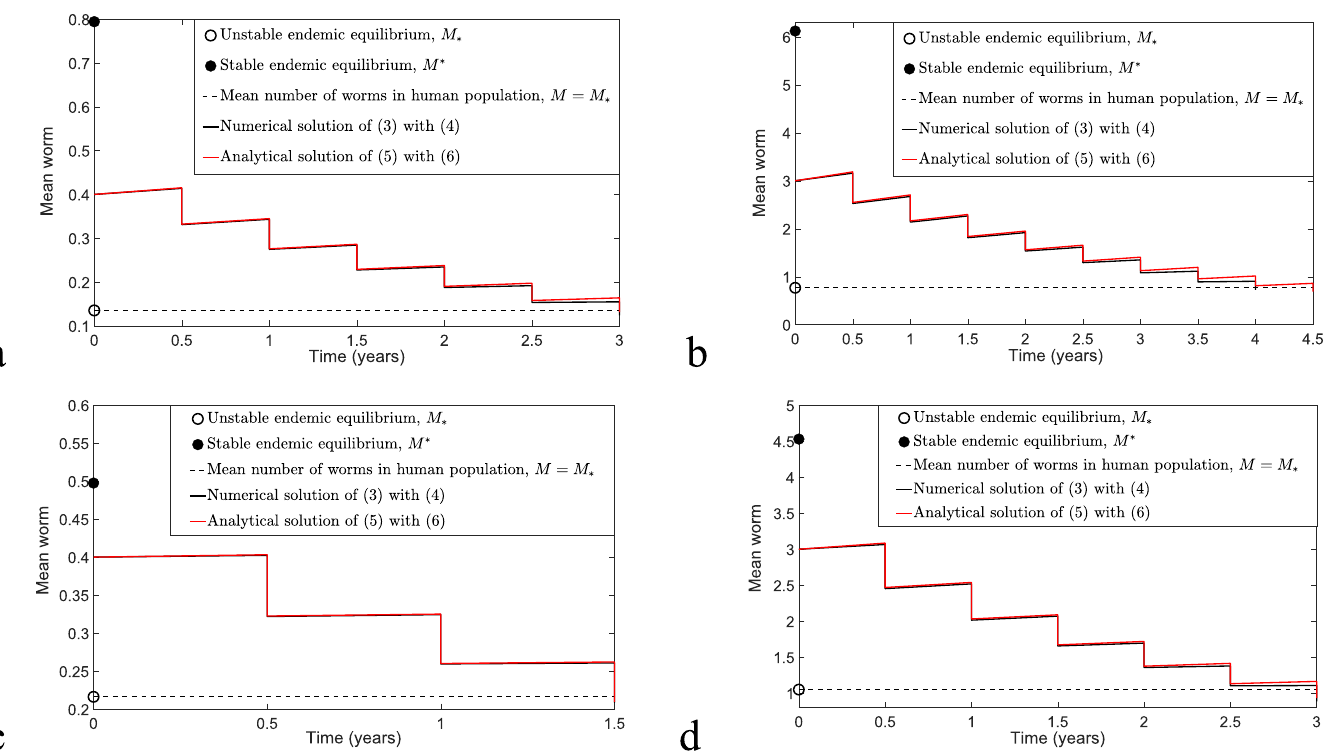
Fig 4. The comparison of the overestimate (5) and (6) and original model (3) and (4) by considering the implementation of biannual MDA with � = 0.4 and ω = 0.5 and varying k and R 0 values. (a) R 0 = 2, k = 0.05, n > 5.83 and MSE = 0.1258 × 10 − 4 . (b) R 0 = 2, k = 0.5, n > 8.34 and MSE = 0.2167 × 10 − 2 . (c) R 0 = 1.8, k = 0.05, n > 2.86 and MSE = 0.5217 × 10 − 6 . (d) R 0 = 1.8, k = 0.5, n > 5.38 and MSE = 0.6392 × 10 − 3